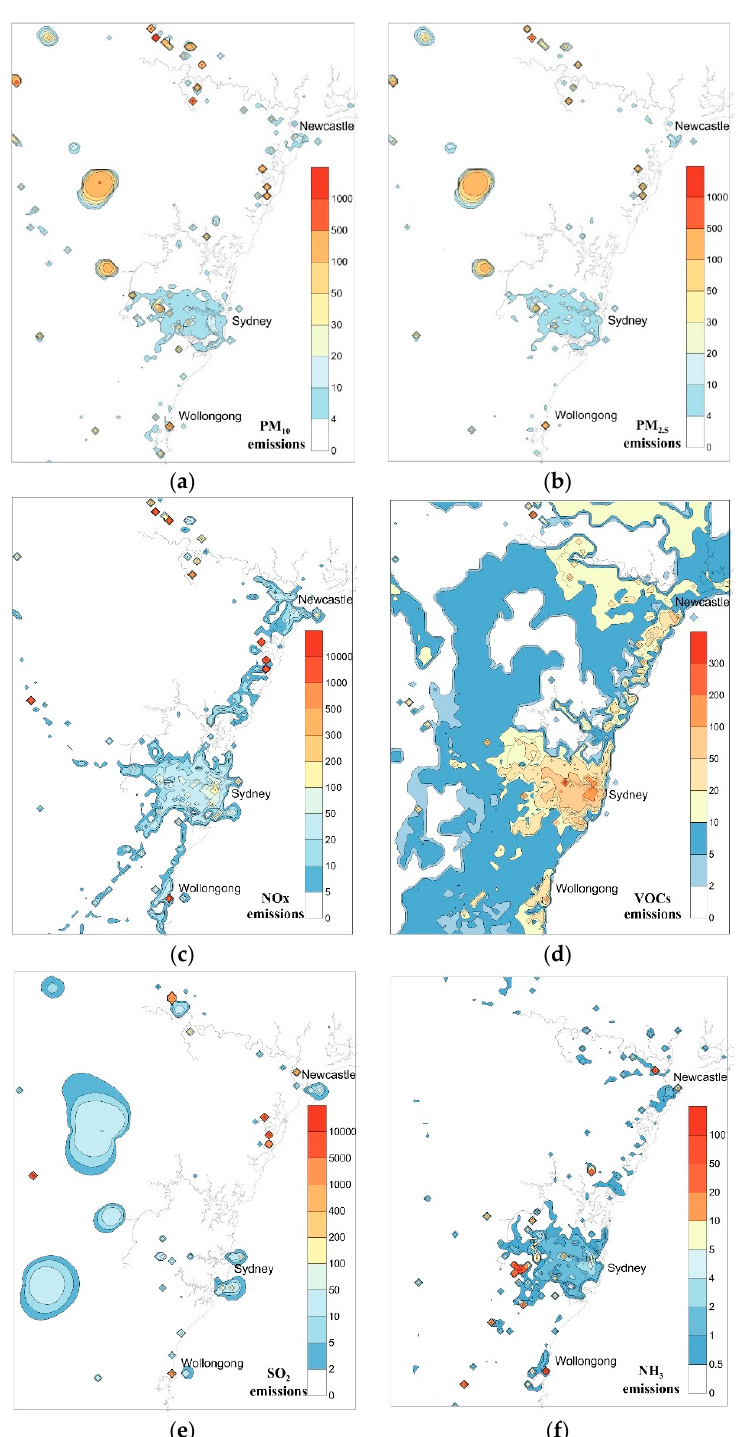
Figure 3. Total emissions (tons/year) of: ( a ) PM 10 ; ( b ) PM 2.5 ; ( c ) NO x ; ( d ) VOCs; ( e ) SO 2 ; and ( f ) NH 3 from the 2008 NSW GMR emission inventory.